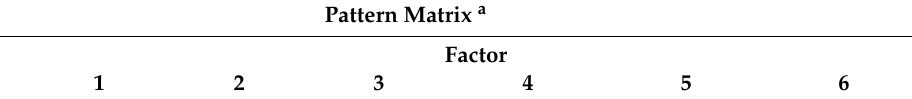
Table 6. Factor loadings.